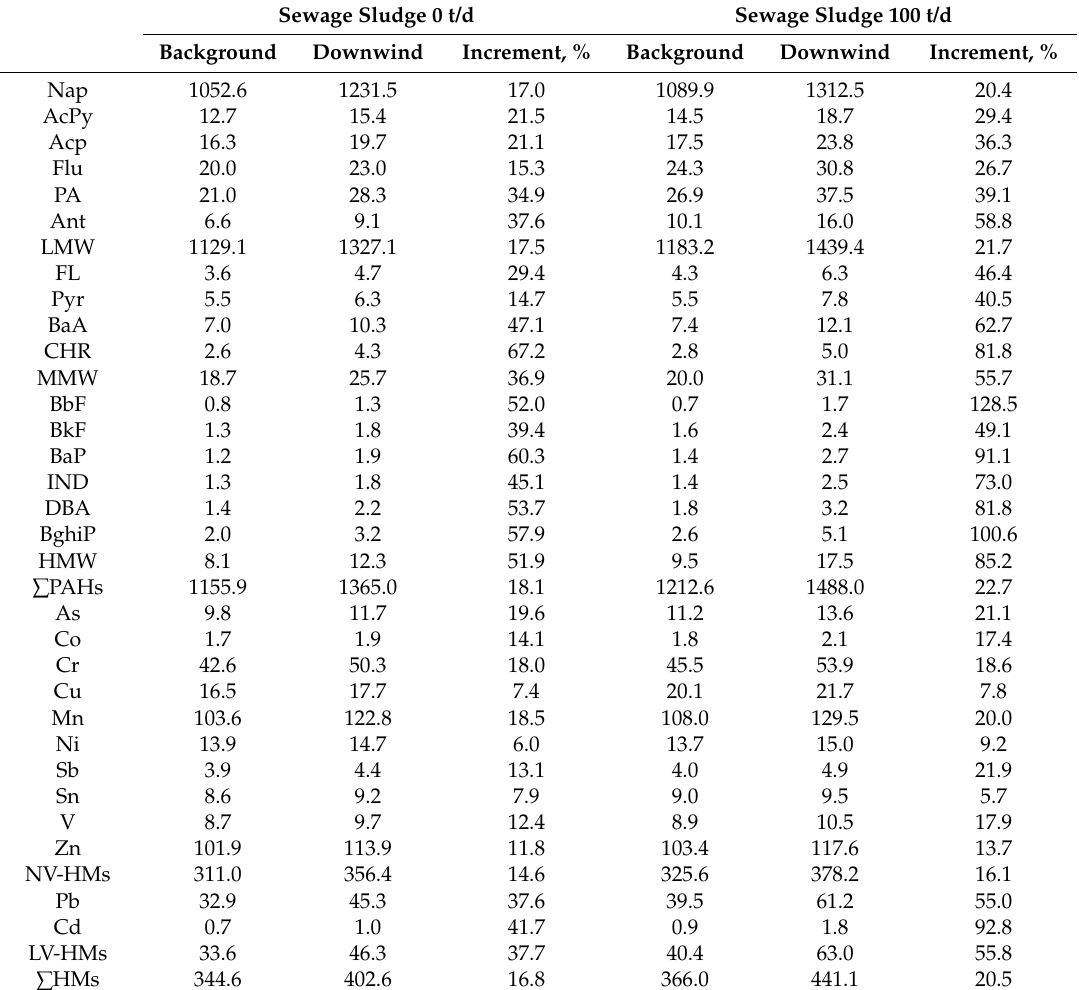
Table 3. Polycyclic aromatic hydrocarbons and heavy metals concentrations in air samples (ng/Nm 3 ). Sewage Sludge 0 t/d Sewage Sludge 100 t/d